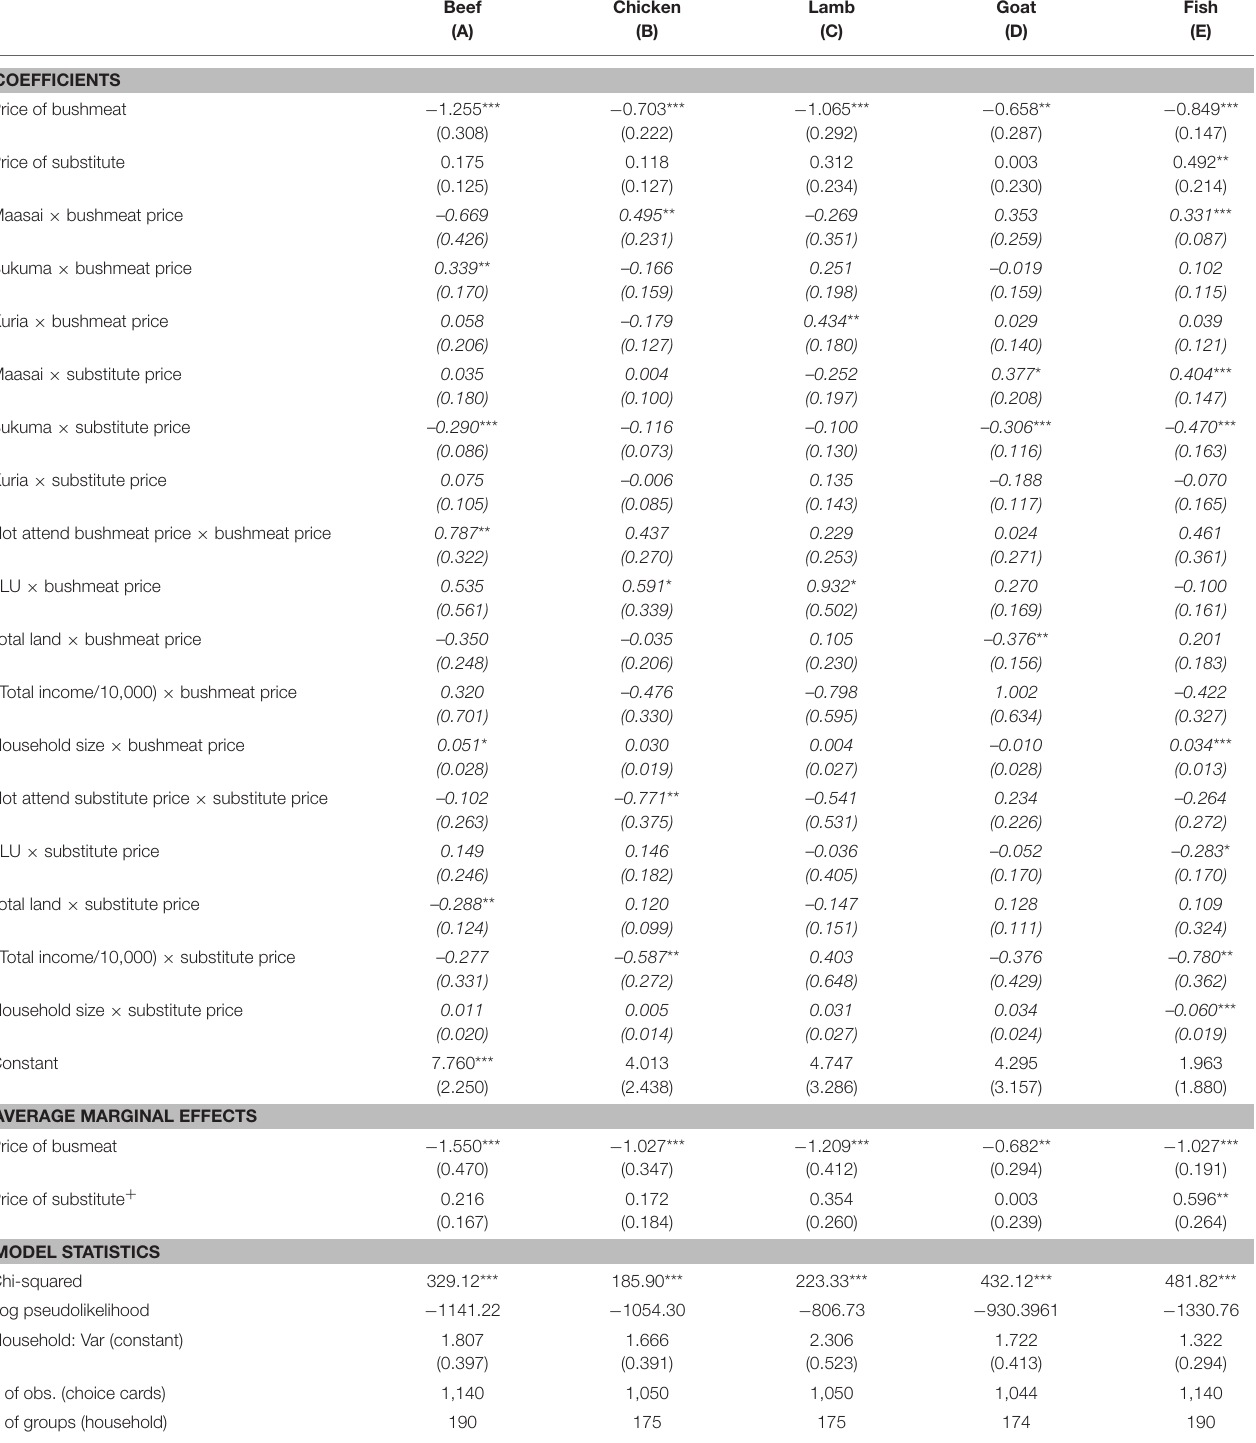
Values in parenthesis are standard errors. Order effect of meat experiment was controlled for in the model—not shown. *** , ** and * reflects significance at the 0.01, 0.05, and 0.1% level respectively. The italic values represent the interaction effects of bushmeat and substitute prices with covariates included in the